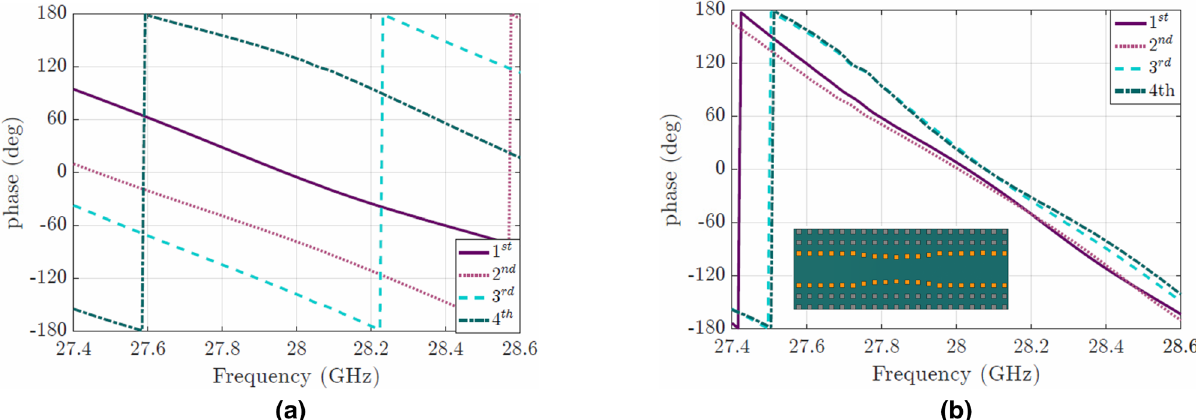
Figure 5. ( a ) Phase after the coupling network ( b ) Corrected phase after placing the phase shifters. In the inset, an example of a phase shifter made in groove gap waveguide technology is presented.